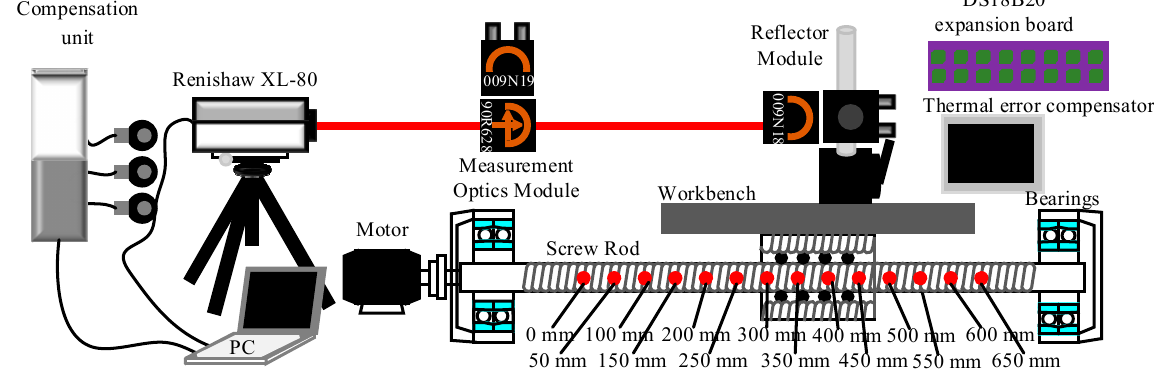
Figure 18. Machine positioning error acquisition solution.